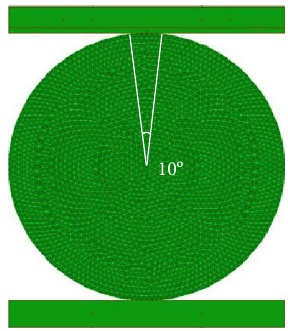
Figure 1: Geometrical model of the